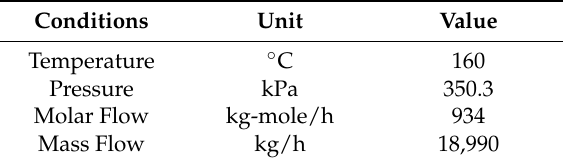
Table 6. Estimated conditions of the feed stream for the MR.